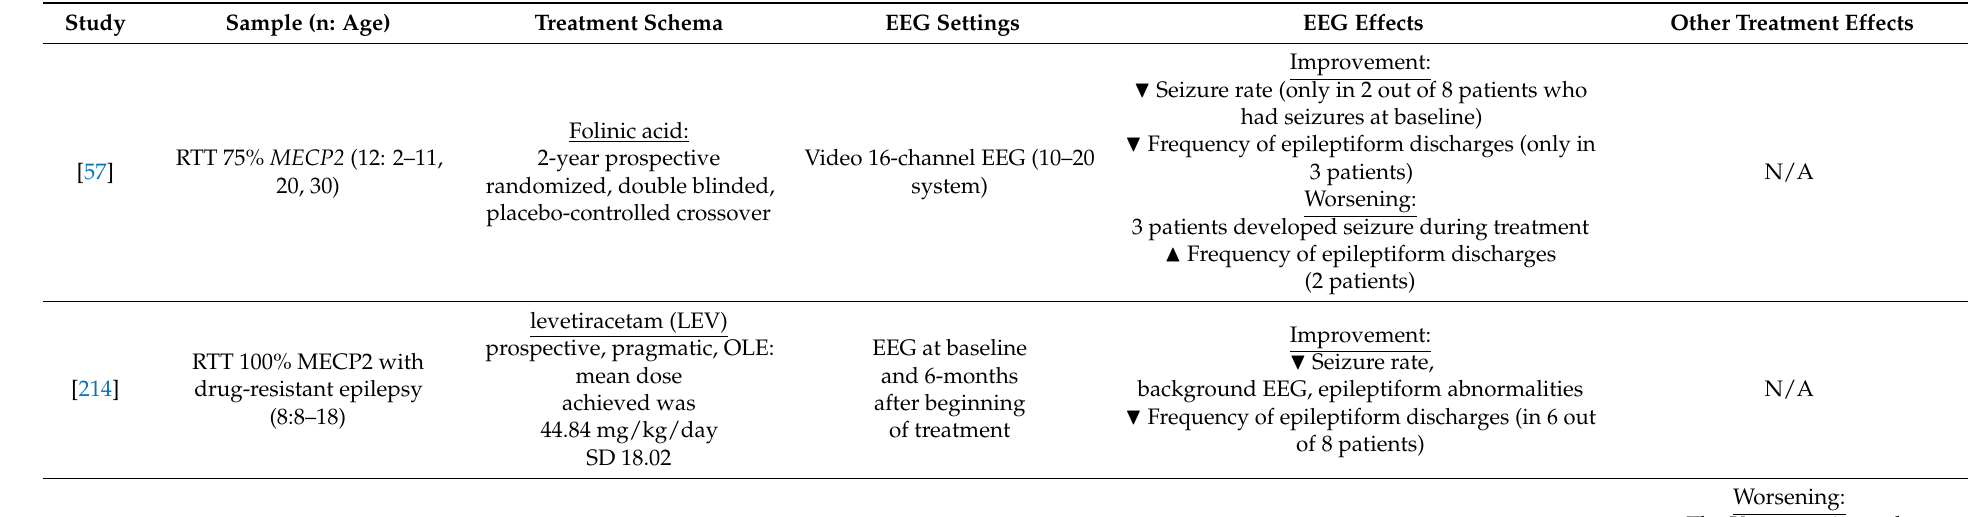
Table 4. Treatment effect on EEG in patients with